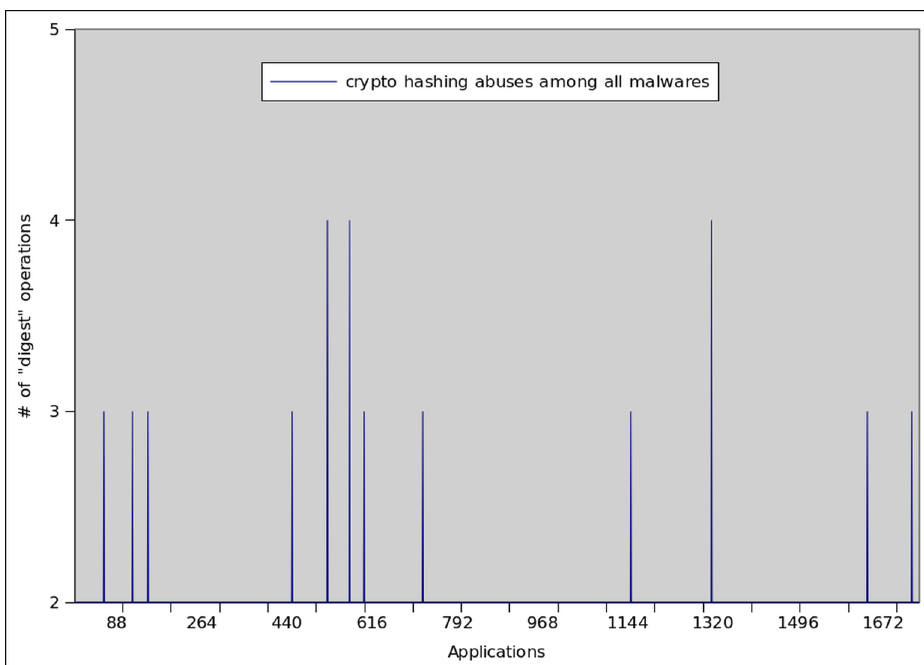
Fig 12. Message digest operations misused by Malware applications.